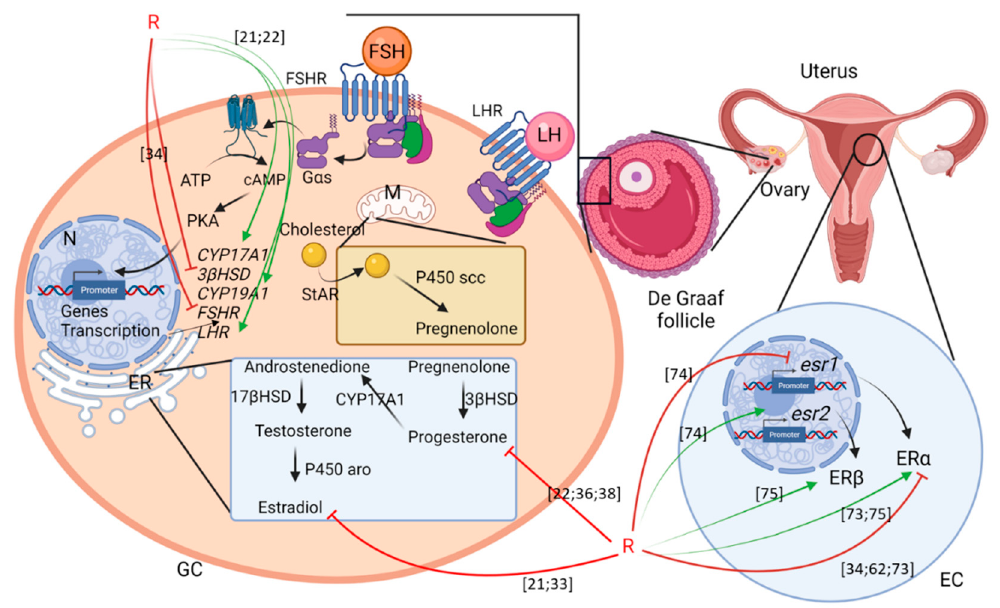
Figure 2. Scheme summering the effects of G or R on female fertility. GC: granulosa cells; EC: endometrial cells; ER: endoplasmic reticulum; M: mitochondria; N: nucleus. Green arrows mean activation and red arrows mean inhibition. Numbering in brackets indicates references.